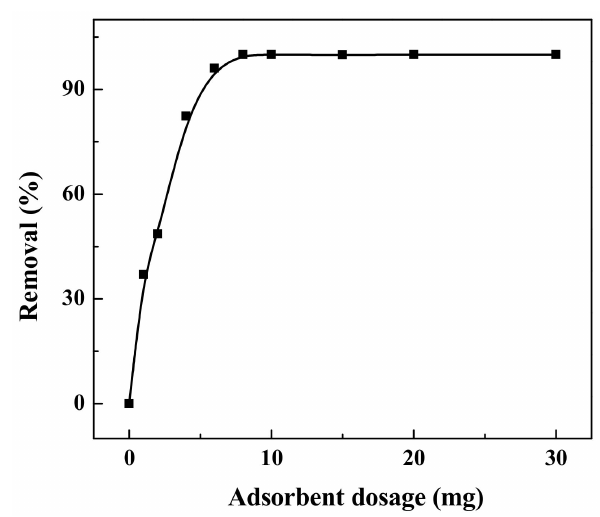
Figure 10. Effect of the adsorbent dosage on the adsorption performance.